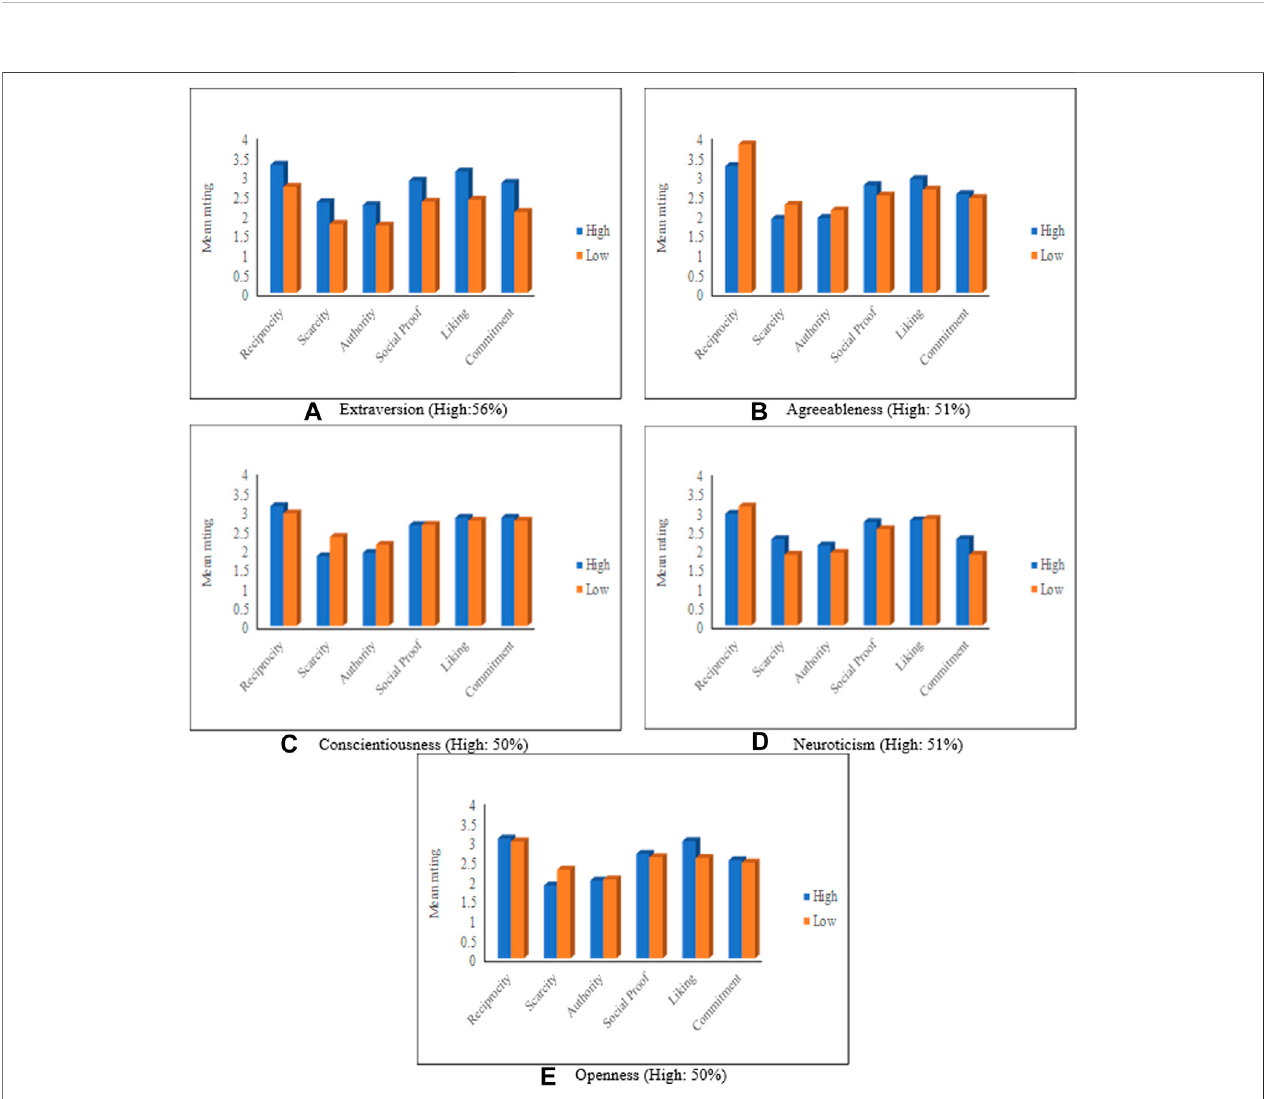
FIGURE 5 | Mean rating based on the personality traits. (A) Extraversion, (B) Agreeableness, (C) Conscientiousness, (D) Neuroticism, (E) Openness.